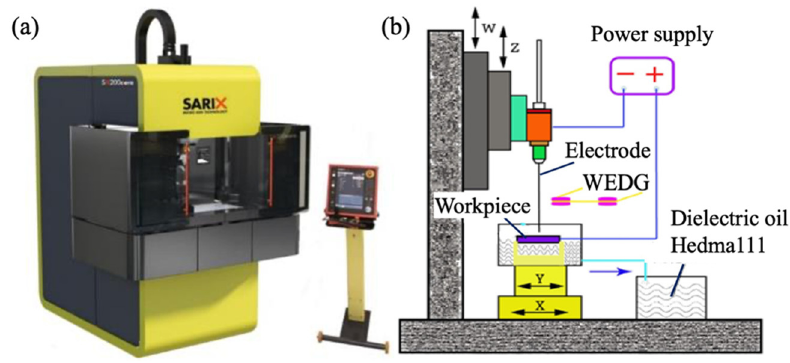
Figure 1: The experimental setup: ( a ) photograph of the experimental setup and ( b ) schematic of the processing area.